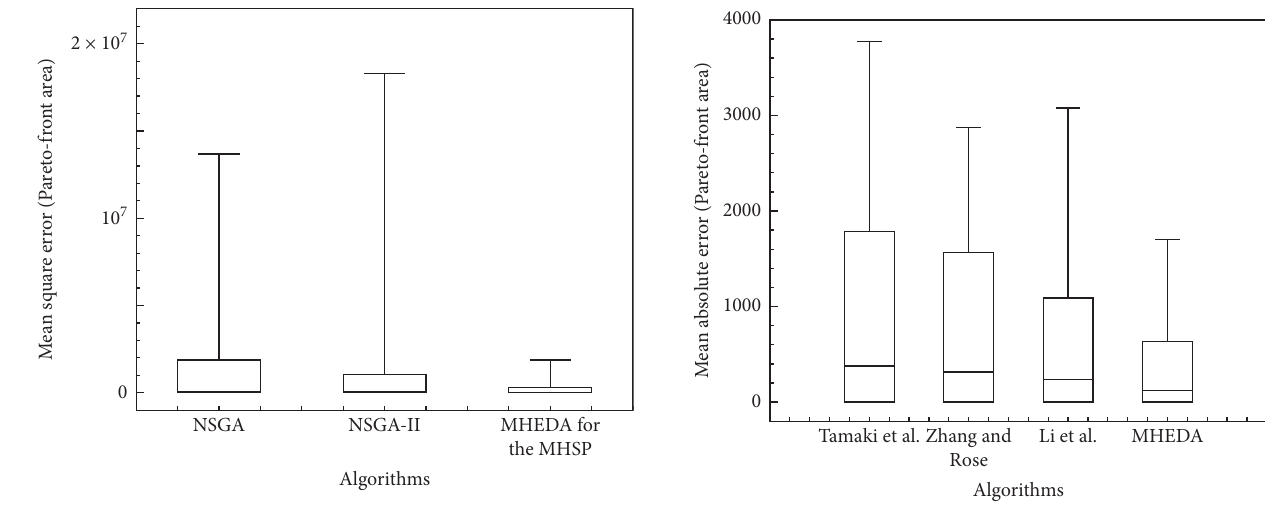
Figure 14: Comparison results for the MHSP using the mean absolute